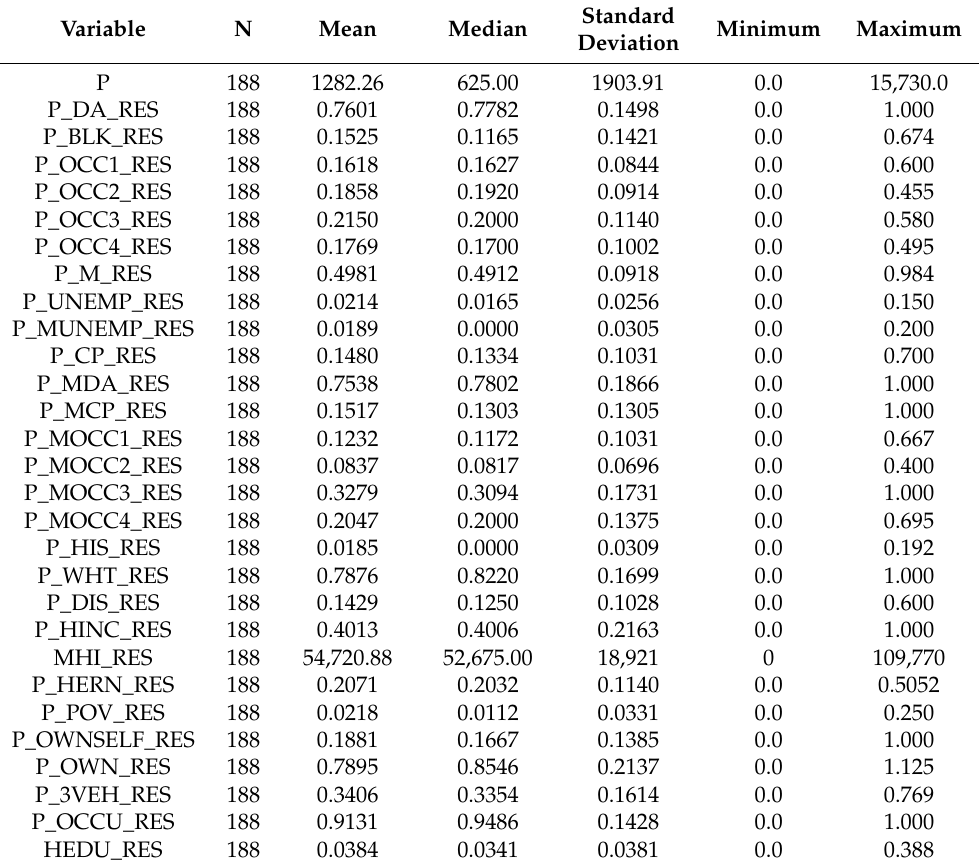
Table 6. Descriptive Statistics for Group A Variables.